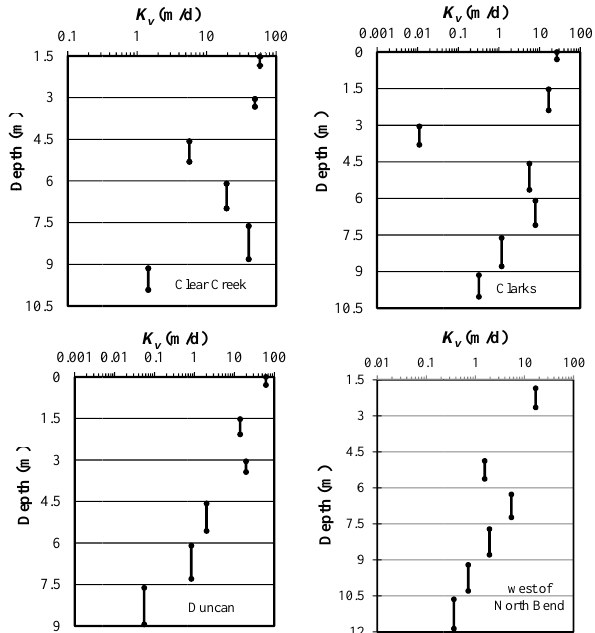
Fig. 4. Distribution of K v with depth in gaining streams for four study sites in eastern Nebraska. Three study sites were located in the Platte River; the other site was located in Clear Creek.